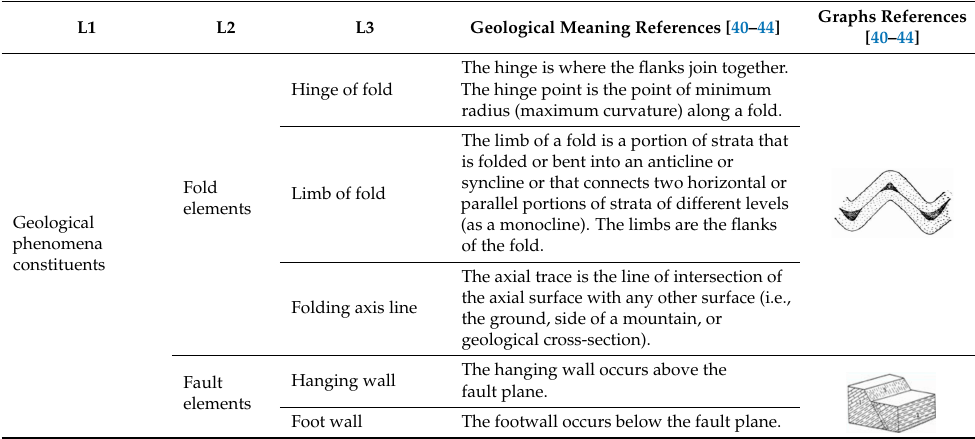
Table 2. Classification of geological relationships.